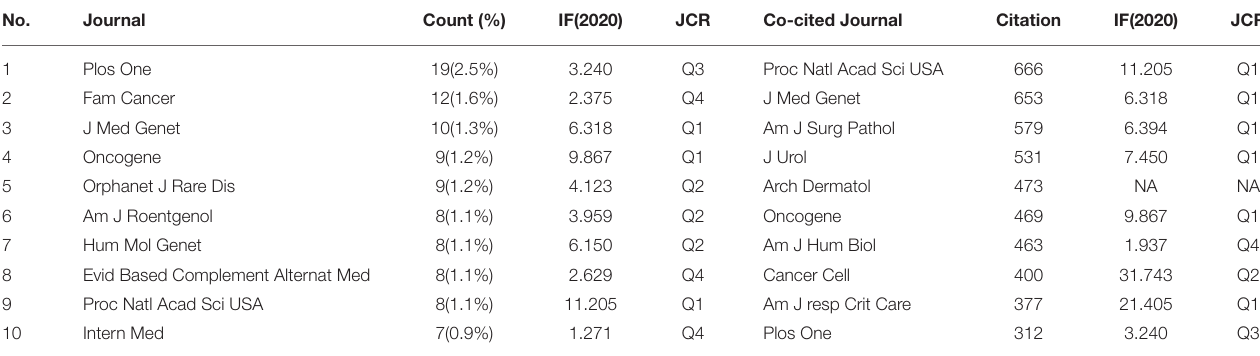
TABLE 5 | The top 10 journals and co-cited journals related to